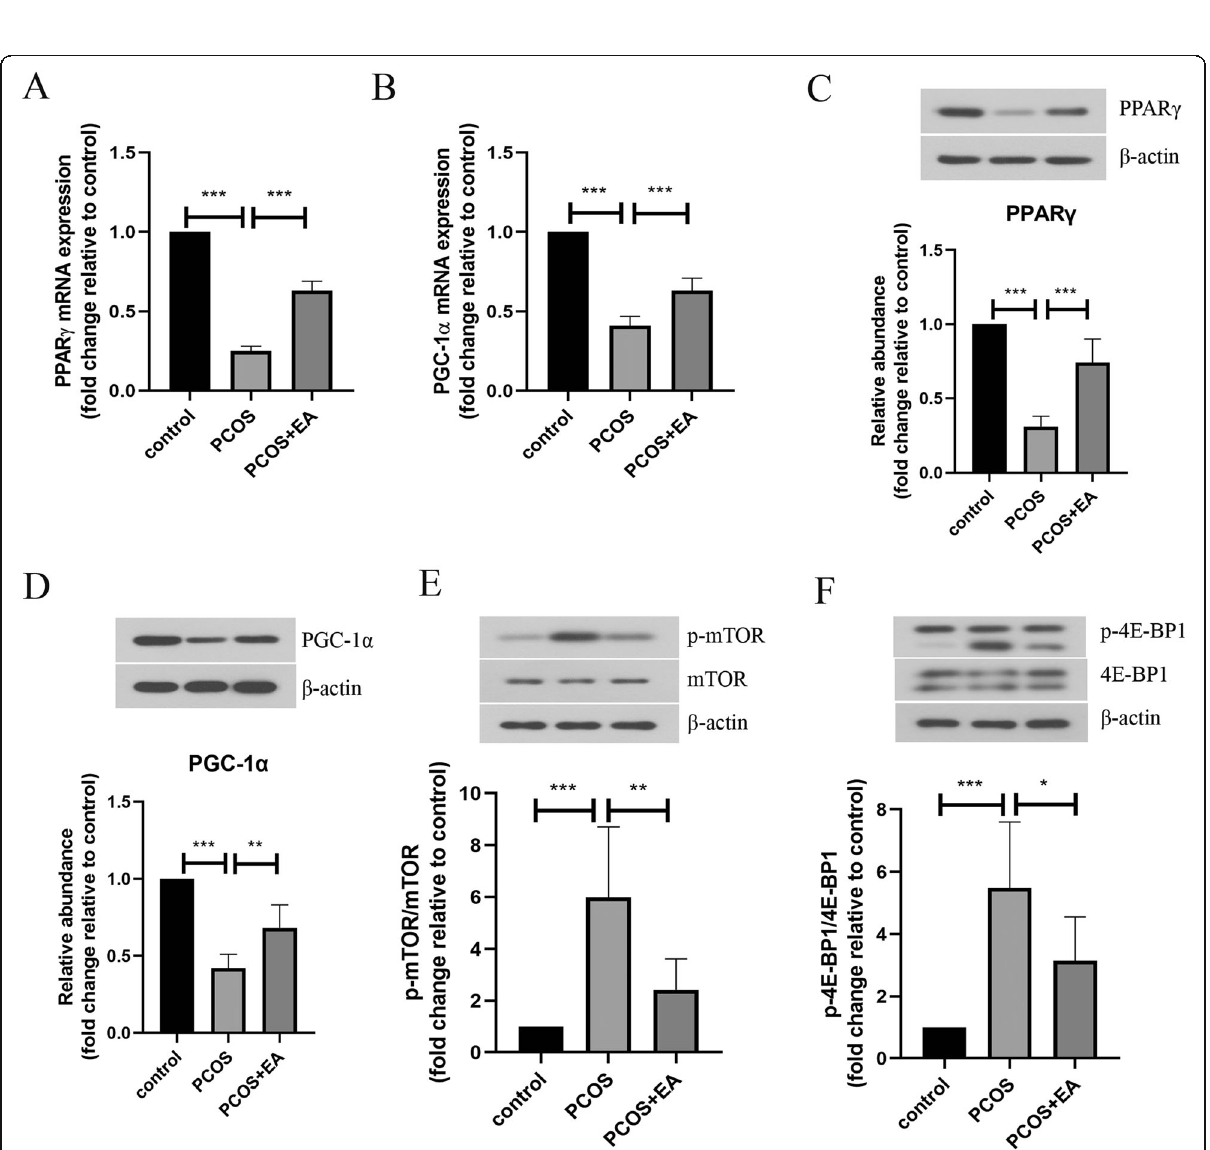
Fig. 4 mTOR/4E-BP1 signaling pathway was involved in the protective effect of EA against insulin resistance. The mRNA expression of PGC-1 α ( a ) and PPAR γ ( b ) in skeletal muscle tissues was assessed by real-time PCR. c-f The protein levels of PPAR γ , PGC-1 α , p-mTOR, mTOR, p-4E-BP1 and 4E- BP1 in skeletal muscle tissues were evaluated by Western blotting. The experimental data are presented as mean ± standard deviation (n = 6). * P < 0.05, ** P < 0.01, *** P < 0.001, vs the indicated group. EA, electroacupuncture; PPAR γ , peroxisome proliferator-activated receptor gamma; PGC- 1 α , PPAR γ coactivator-1 α . mTOR, mechanistic target of rapamycin; 4E-BP1, 4E-binding protein